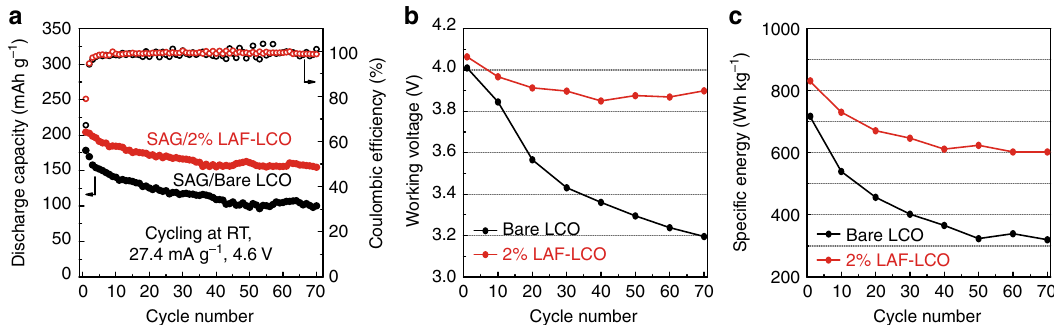
Fig. 6 Electrochemical performance of synthetic arti fi cial graphite (SAG)/bare LCO or 2% LAF-LCO full cells. a Cycle performance of full-cells with bare LCO or 2% LAF-LCO electrodes at room temperature in the voltage range of 3.0 – 4.6 V (vs. graphite) at a current density of 27.4 mA g − 1 . b , c Working voltage and speci fi c energy of full-cells with bare LCO or 2% LAF-LCO electrodes. Source data are provided as a Source Data